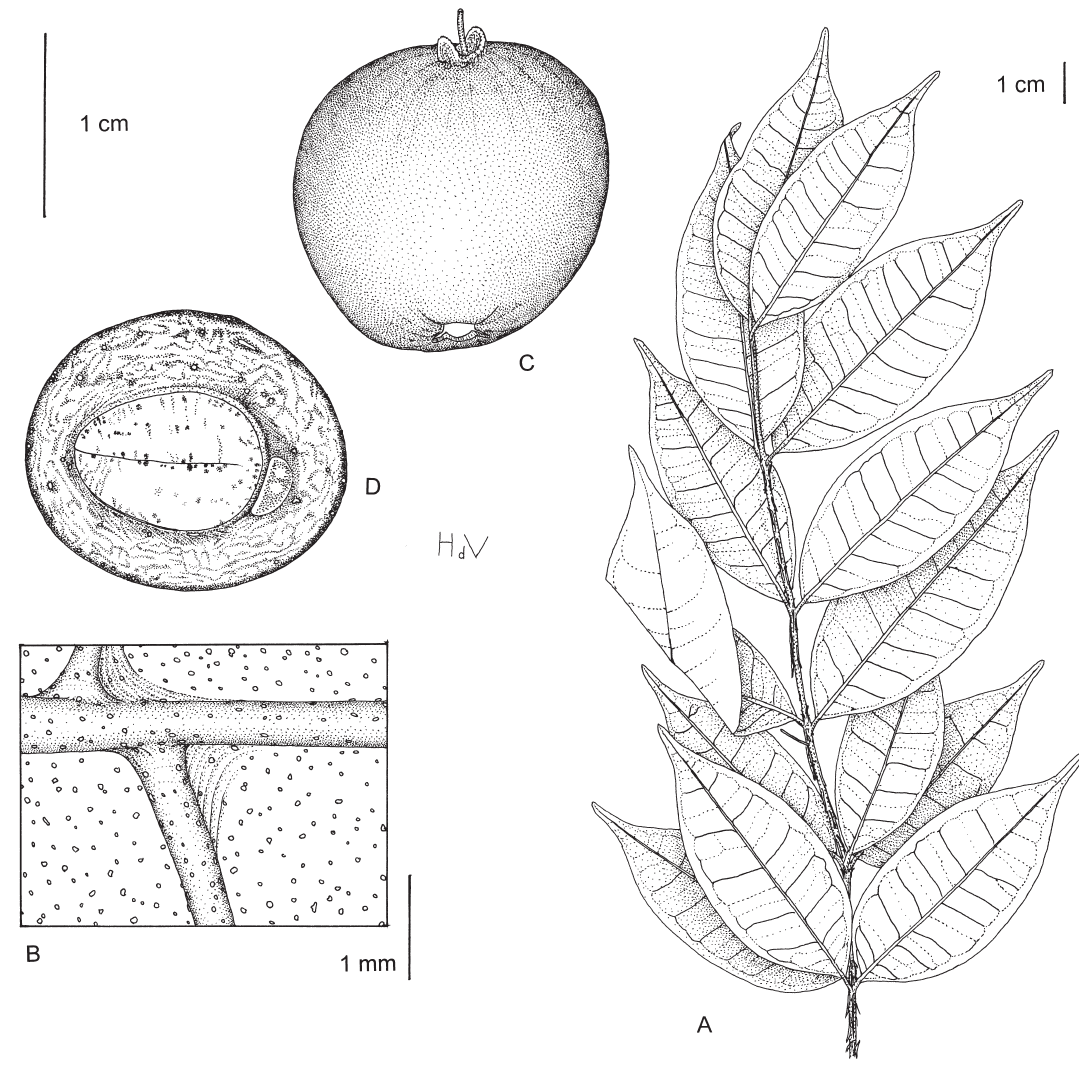
Fig. 4. Eugenia breteleri sp. nov. A . Branch with leaves. B . Detail of leaf from below showing secretory cavities. C . Fruit (from pickled specimen) with style and part of the calyx still present. D . Cross section of fruit and single seed. A & B from Breteler 11457 , C & D from Breteler 11546 . Drawing by Hans de